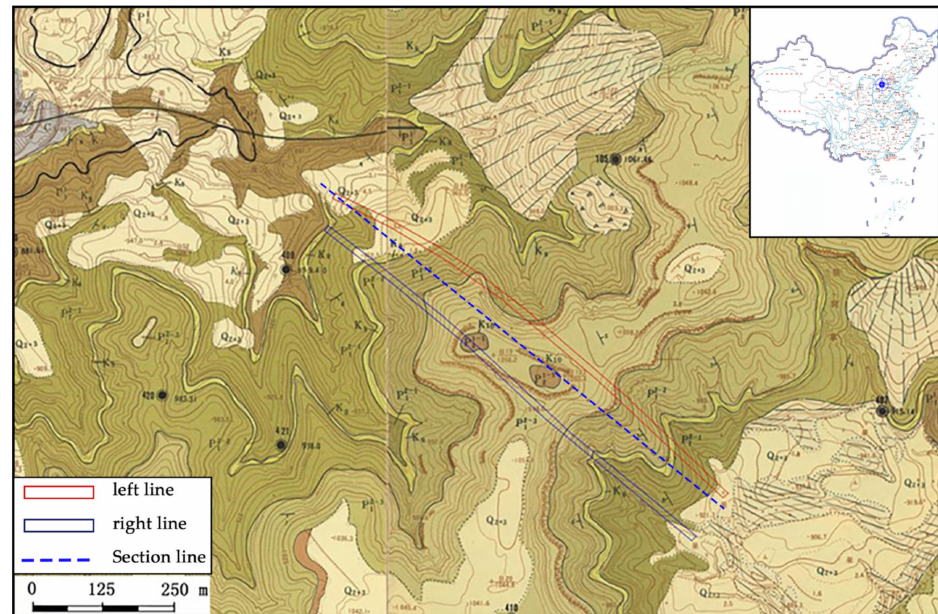
Figure 1. Location and geology of the Tianzimiao tunnel (the red one is left line and blue